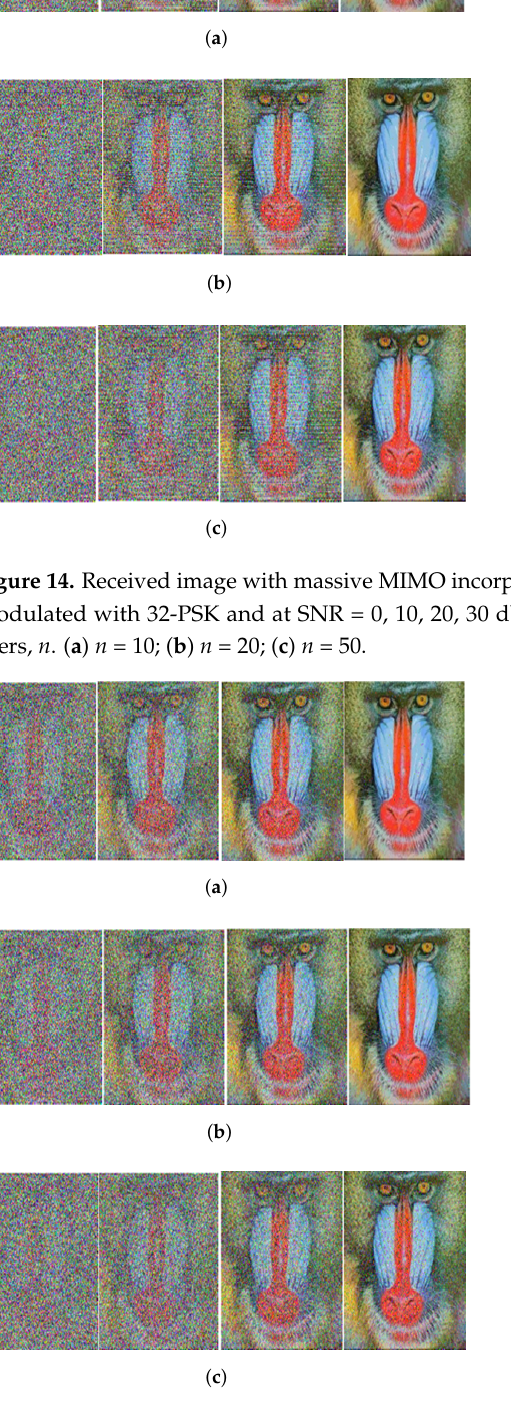
Figure 15. Received image with massive MIMO incorporated FRFT-OFDM over a Rayleigh channel, Modulated with 64-PSK and at SNR = 0, 10, 20, 30 dB from Left to Right for different number of users, n . ( a ) n = 10; ( b ) n = 20; ( c ) n =